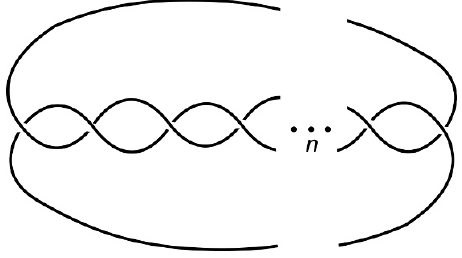
Figure 5 . The T (2 ; 2 n ) link, where the two circles are twisted n number of times. There are 2 n crossings and the linking number is n